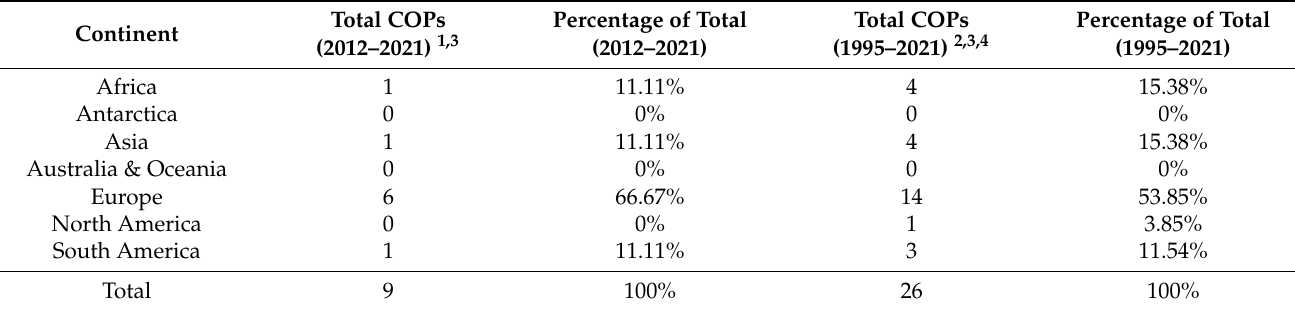
Table 7. Geographic distribution of UNFCCC COPs through